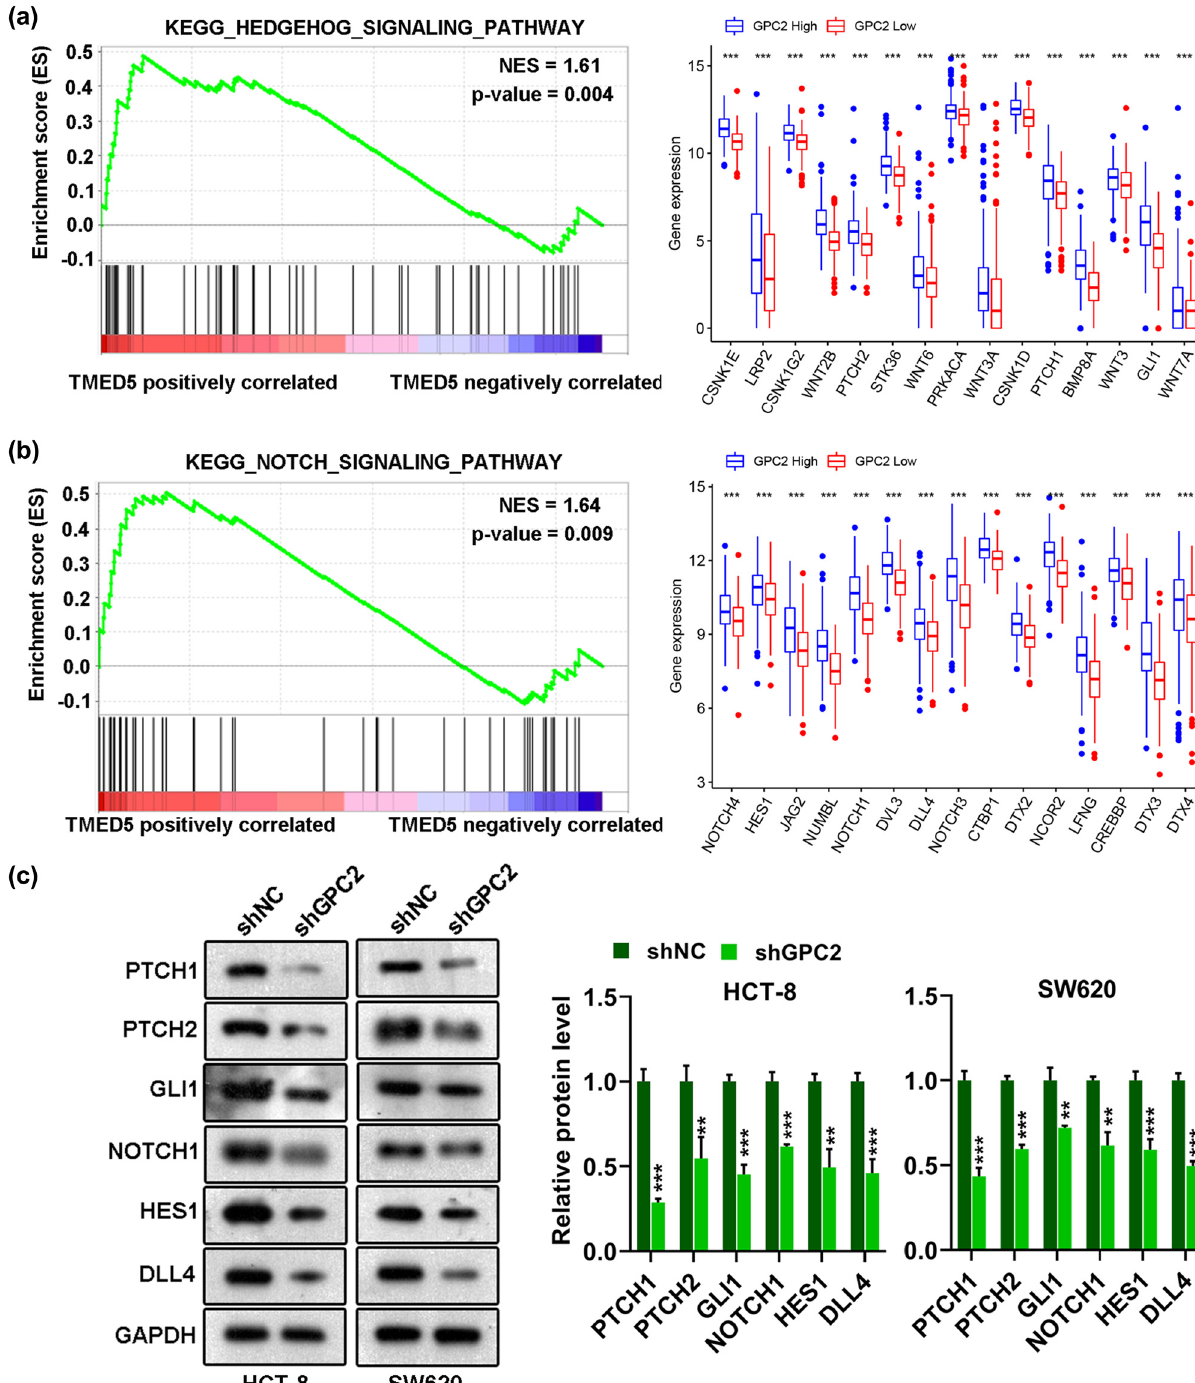
Figure 4: Prediction of pathways involved in GPC2: ( a and b ) the genes co - expressed with GPC2 in COAD tissues were enriched in ( a ) notch signaling and ( b ) hedgehog signaling and ( c ) After transfection of shNC, shGPC2 into HCT - 8 and SW620 cells, the protein levels of PTCH1, PTCH2, GLI1, NOTCH1, HES1, and DLL4 were detected by Western blotting ( n = 3 ) . KEGG: Kyoto Encyclopedia of Genes and Genomes. ** P < 0.01, *** P <